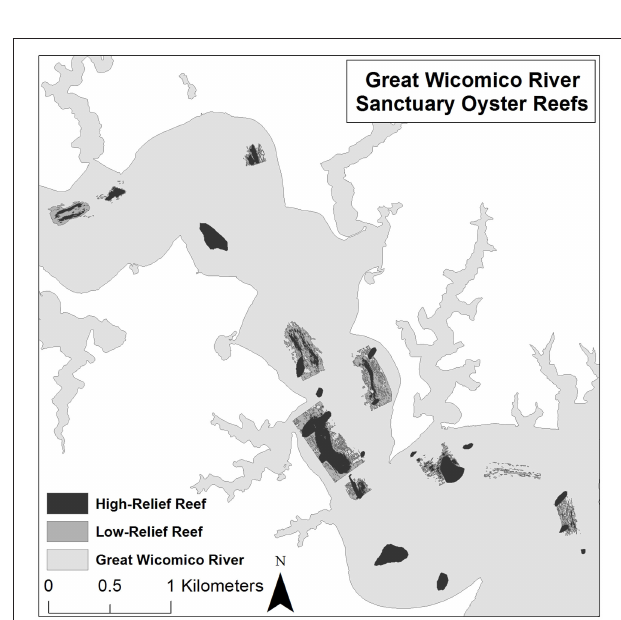
FIGURE 3 | Distribution of high-relief reefs (HRR) and low-relief reefs (LRR) in the US Army Corps of Engineers network of sanctuary reefs in the Great Wicomico